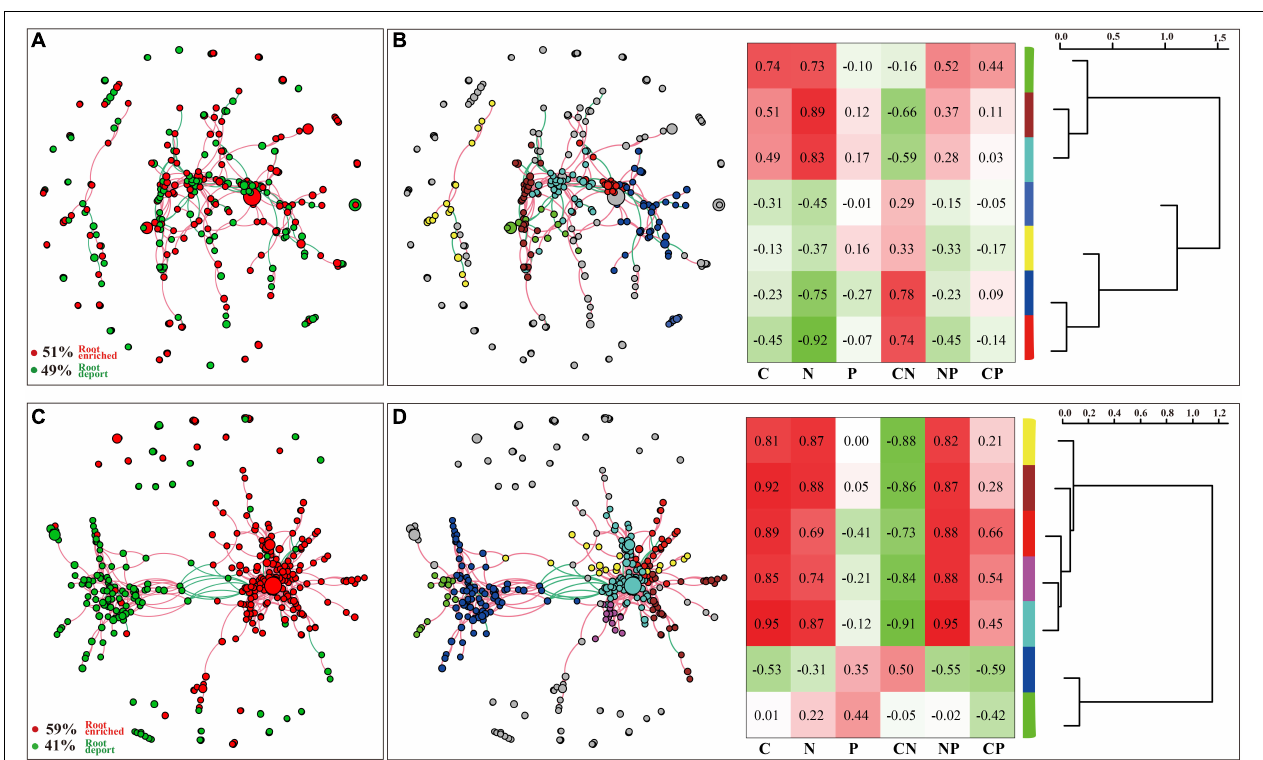
FIGURE 4 | (A,C) DESeq2 differential abundance indicates the enrichment and deportation of OTUs within the overall area of three zones in two WT and TG, respectively. Each node represents an individual OTU, and the red edge is drawn between OTUs if they are positively correlated, while the green edge is drawn between OTUs if they are negatively correlated. (B,D) OTUs are divided into seven modules using the molecular ecological network analyses (MENAP), indicating the ecological network relationship between OTUs. Module-Eigen Gene analyses indicates the Module correlation with environmental factors and the Module-Eigen Gene hierarchy structure. The heatmap shows the correlation between modules and environmental factors, and the hierarchy clustering located on the right shows the Pearson correlation among module eigengenes.